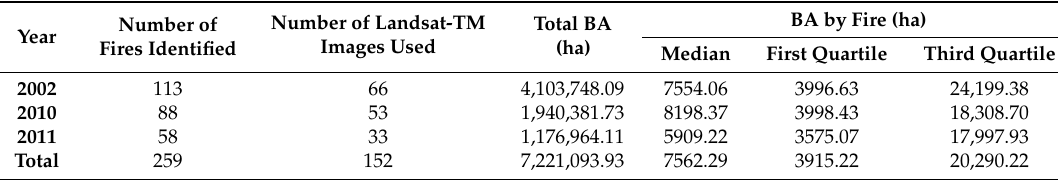
Table 3. Reference BA data from Landsat-TM